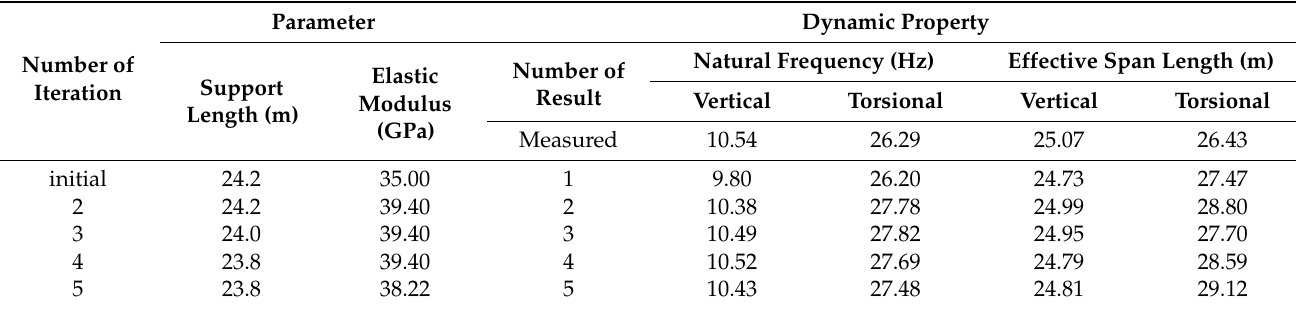
Table 6. Numerical model updating process of the Maeaji Bridge.